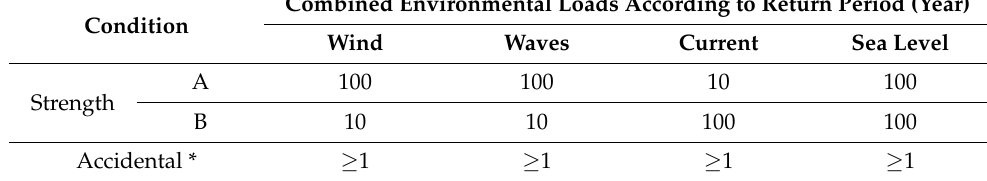
Table 6. DNV’s combinations of environmental loads for offshore